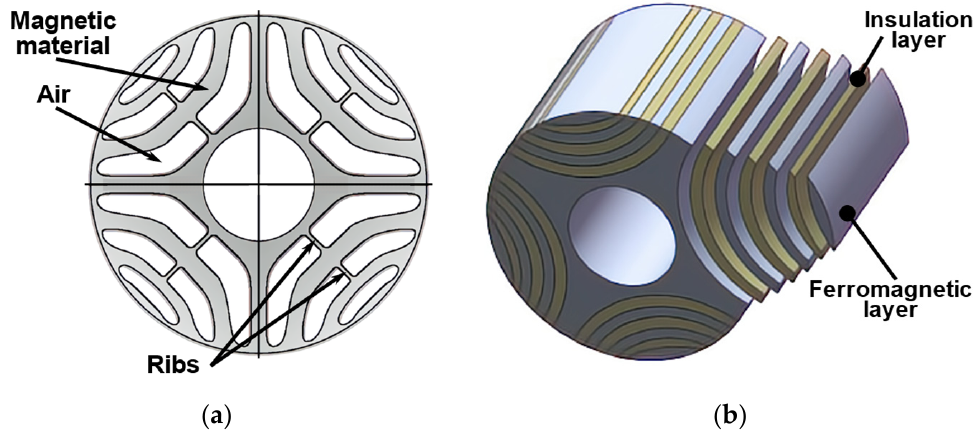
Figure 15. SyncRel rotor constructions. ( a ) With fluid-shaped flux barriers [166]; ( b ) ALA rotor made of bent laminations [167].